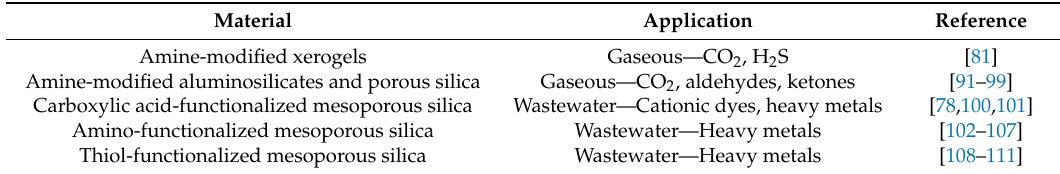
Table 2. Silica nanomaterials and applications in environmental remediation of contaminants